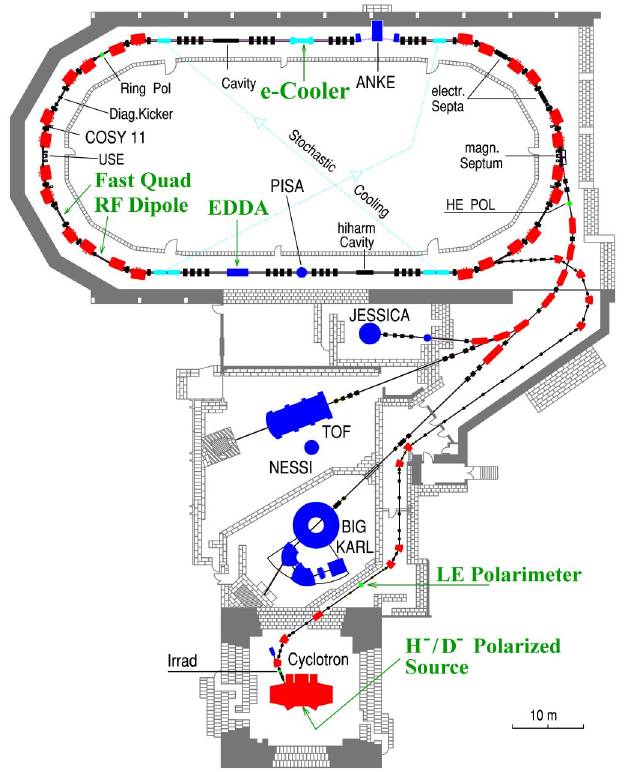
FIG. 4. (Color) Layout of the COSY storage ring, with its injector cyclotron and polarized ion source. Also note the rf dipole, the fast quadrupole, EDDA, the low energy (LE) polar- imeter, and the electron Cooler.